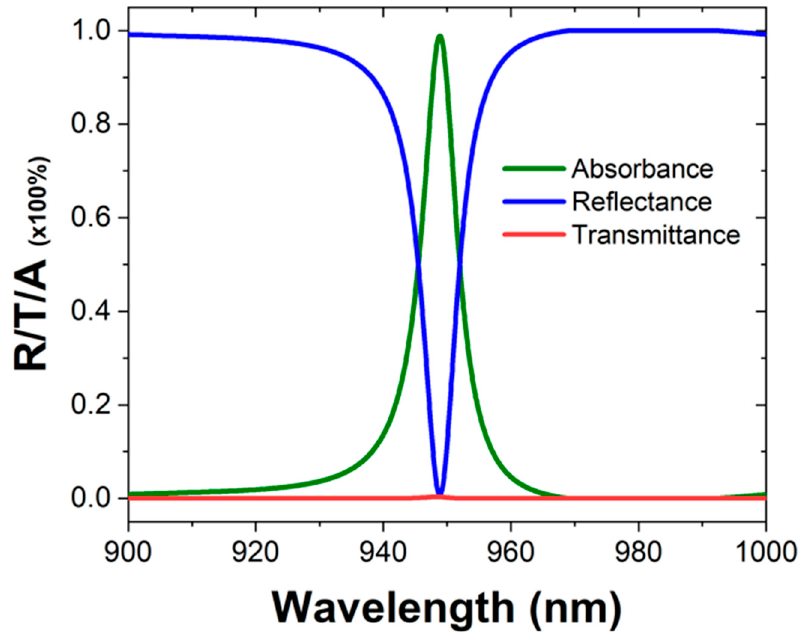
Figure 4. R/T/A output spectra of the CO 2 gas sensor.